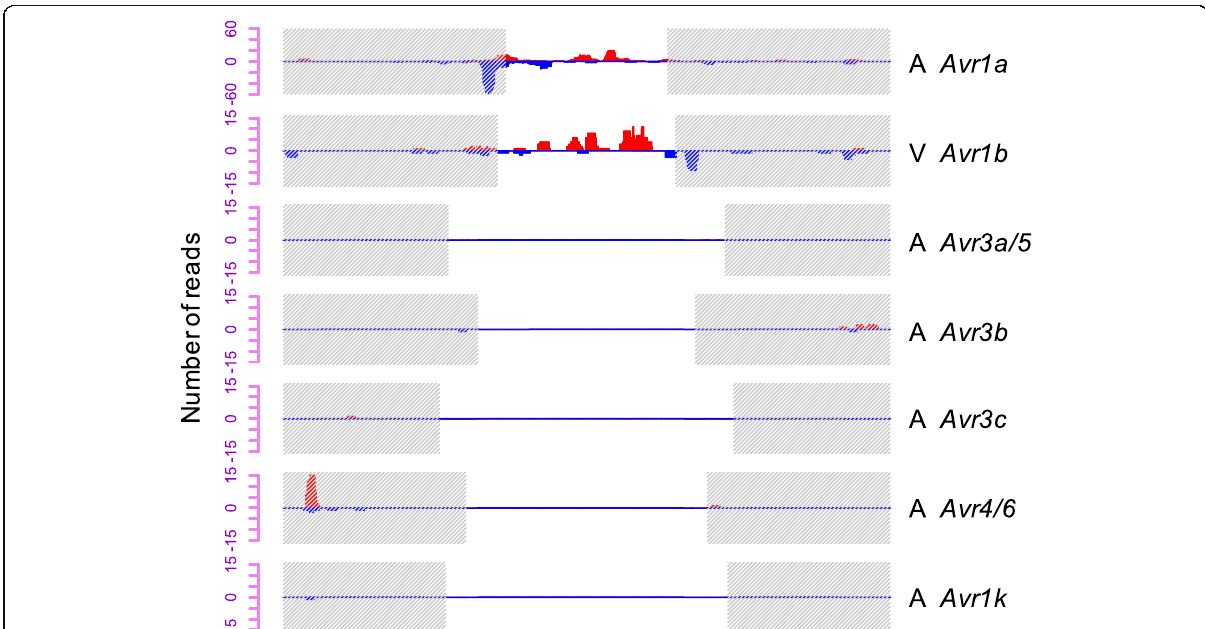
Fig. 3 The abundance distribution of sRNA reads homologous to the functional Avr genes in P. sojae strain P6497. The sense sRNA reads (above the x-axis) are shown in red, and the antisense sRNA reads (below the x-axis) are shown in blue. The shaded regions indicate the 5 ′ or 3 ′ 500bp flanking